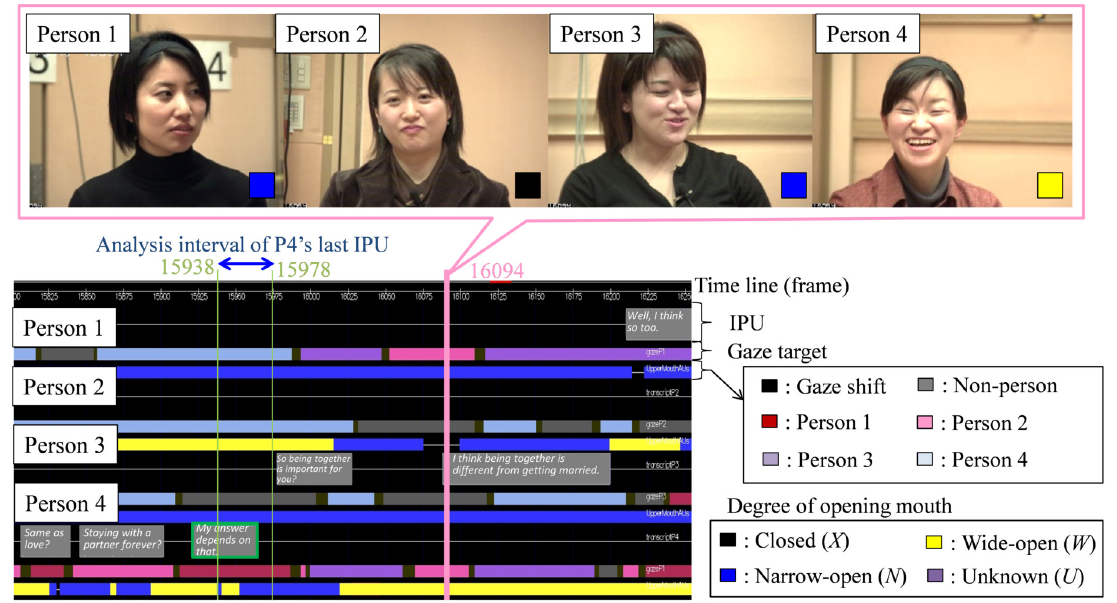
Figure 3. Sample image of displayed verbal and nonverbal data with NTT Multimodal Viewer [41]. The top shows the face image of each participant in the 16094th frame. At the bottom is the verbal and non-verbal behavior of each participant. Upper gray boxes show inter-pausal units (IPUs), middle boxes show eye-gaze targets and lower boxes show the degrees of mouth-opening for each person along the